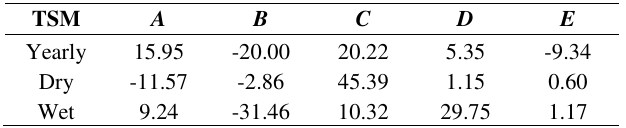
Table 3. Regression coefficient values for TSM models.